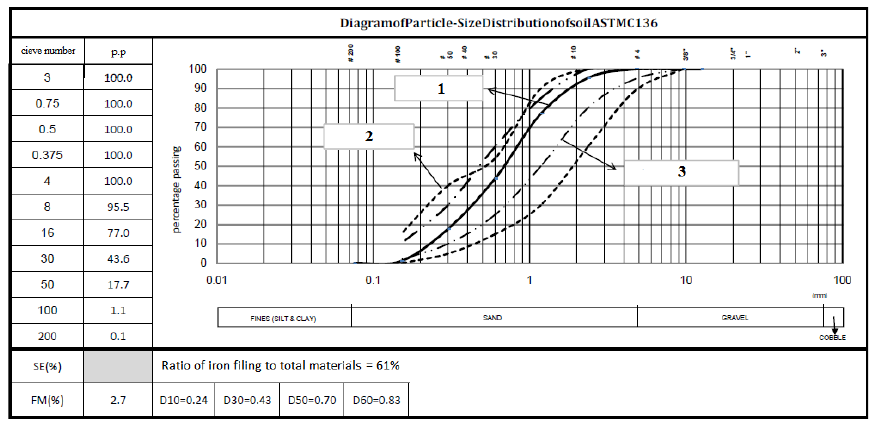
Fig. 6. Hydrocyclone grading curve with one inlet gate (1: Grading curve, 2: Grading envelope according to Building Regulations of Iran [9], 3: Grading envelope according to Iranian Road Construction [10]